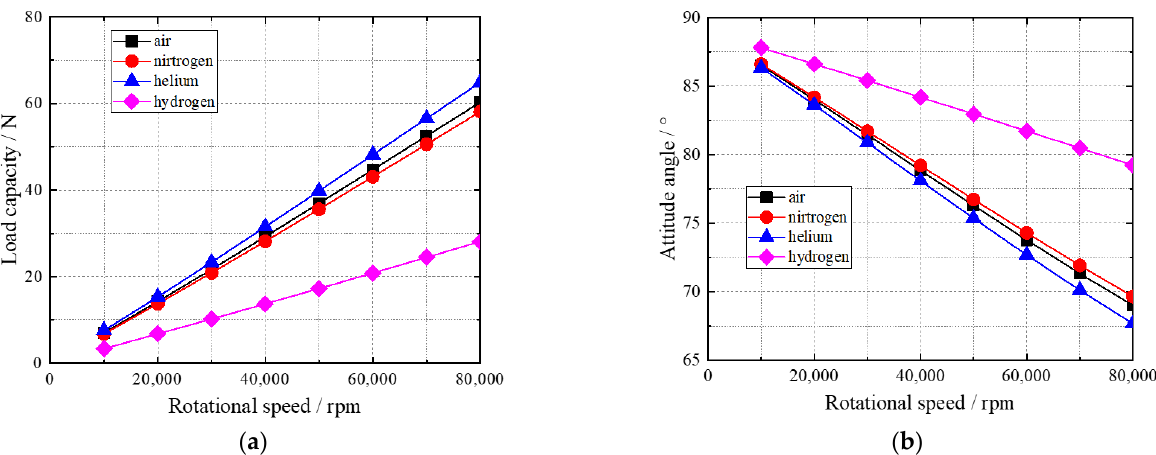
Figure 6. ( a ) Load capacities and ( b ) attitude angles with rotational speed using four different gases. The friction torque with rotational speed obtained for the four different gases is shown in Figure 7. The values of bearing friction torque using air, nitrogen and helium are relatively close to one another. Throughout the whole speed range, the bearing friction torque using hydrogen is the lowest. In addition, the friction torque increases linearly with rotational speed.